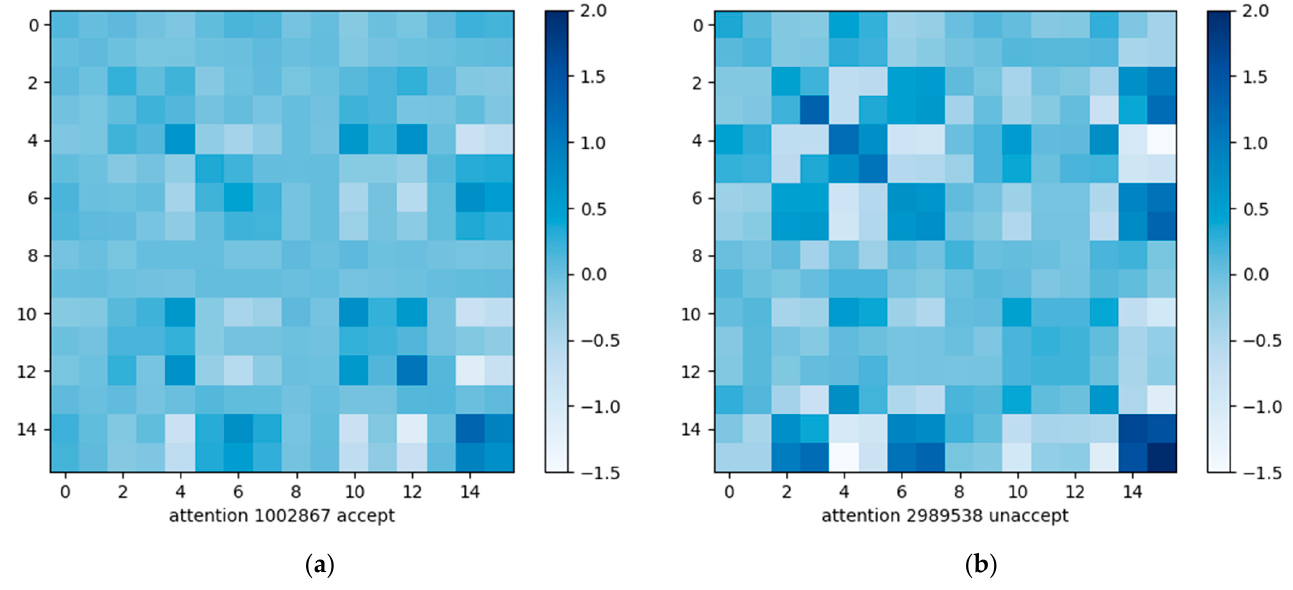
Figure 7. ( a ) Attention matrix of an acceptable sample; ( b ) attention matrix of an unacceptable sam- ple.